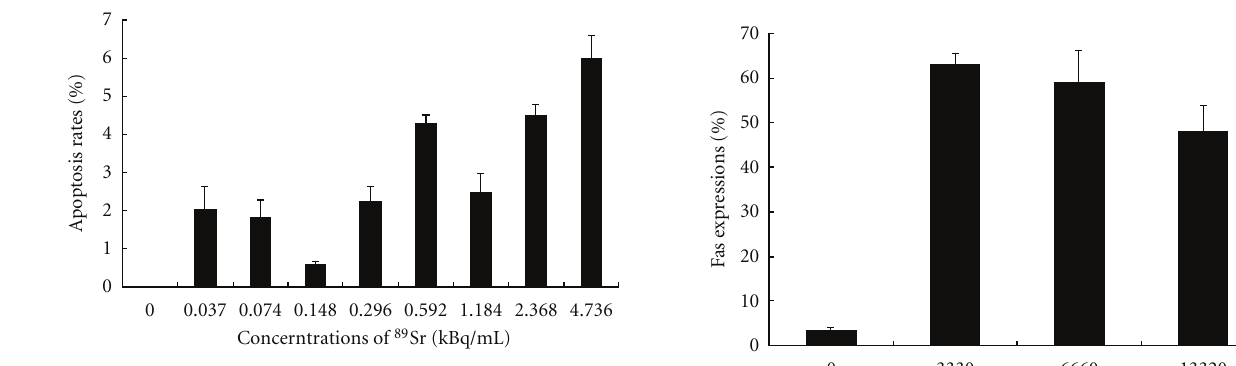
Figure 4: Percentage of MCF-7 cell apoptosis due to being induced by 89 Sr of various radioactive concentrations.